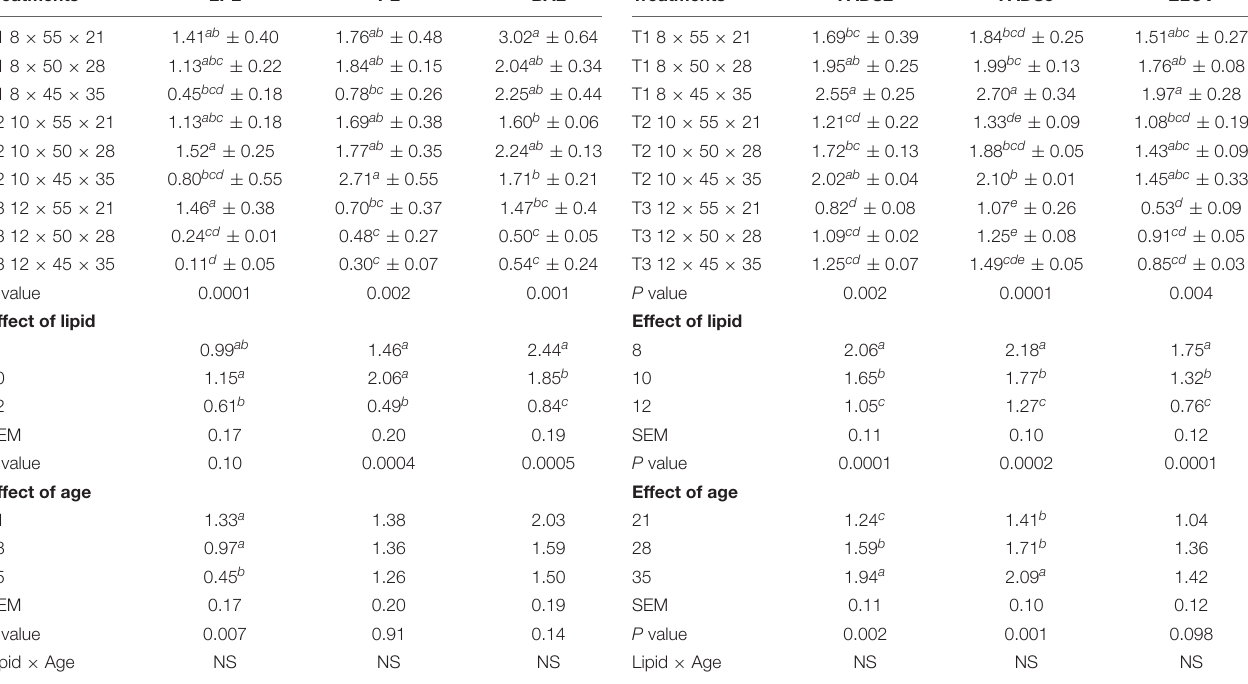
TABLE 6 | Effects of dietary lipid levels and age on the expression of fatty acid synthesis related genes of C. magur. Treatments